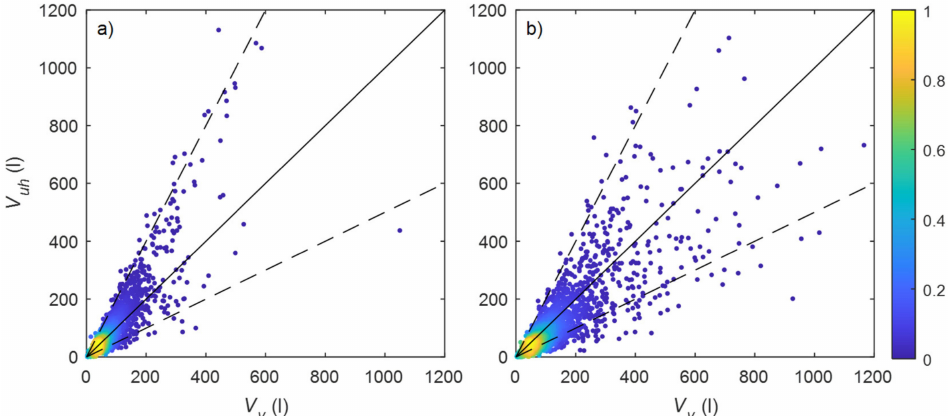
Figure 5. Comparison of event-by-event overtopping volume estimates obtained using the peak volume ( V v ) and sum of positive discharge ( V uh ) methods during ( a ) 1DR and ( b ) 2DR. The solid black line represents V v = V uh and the black dashed lines indicate a factor of 2 range about the 1:1 line. The colour scale indicates the normalised point